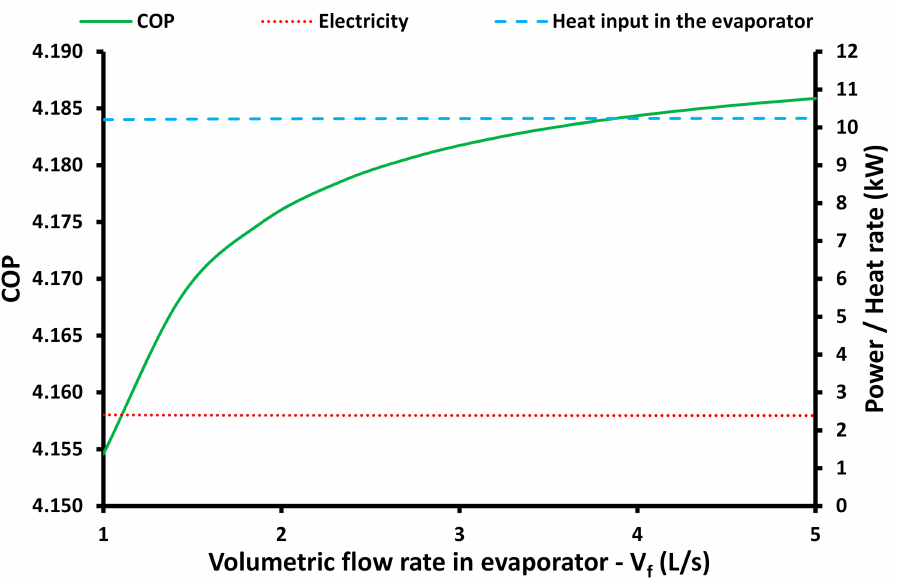
Figure 10. The impact of the volumetric flow rate in the evaporator on the COP, electricity consump- tion and heat input in the